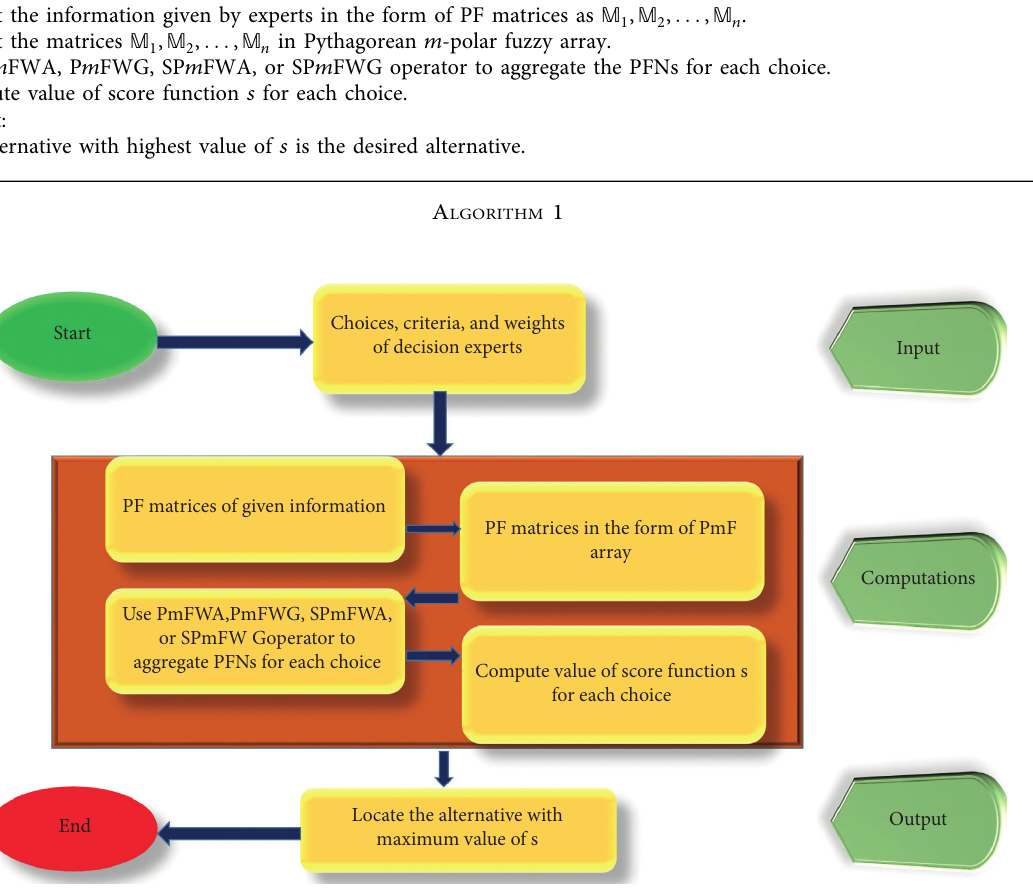
Figure 2: Flowchart of the algorithm.